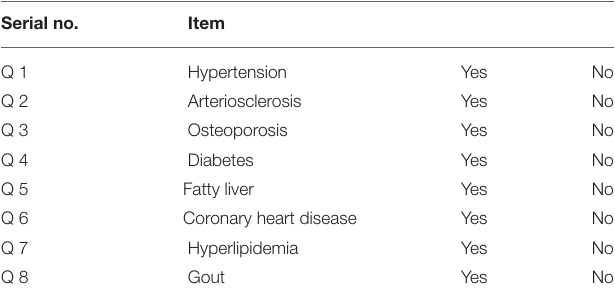
TABLE 1 | Chronic disease survey scale of resident. Serial